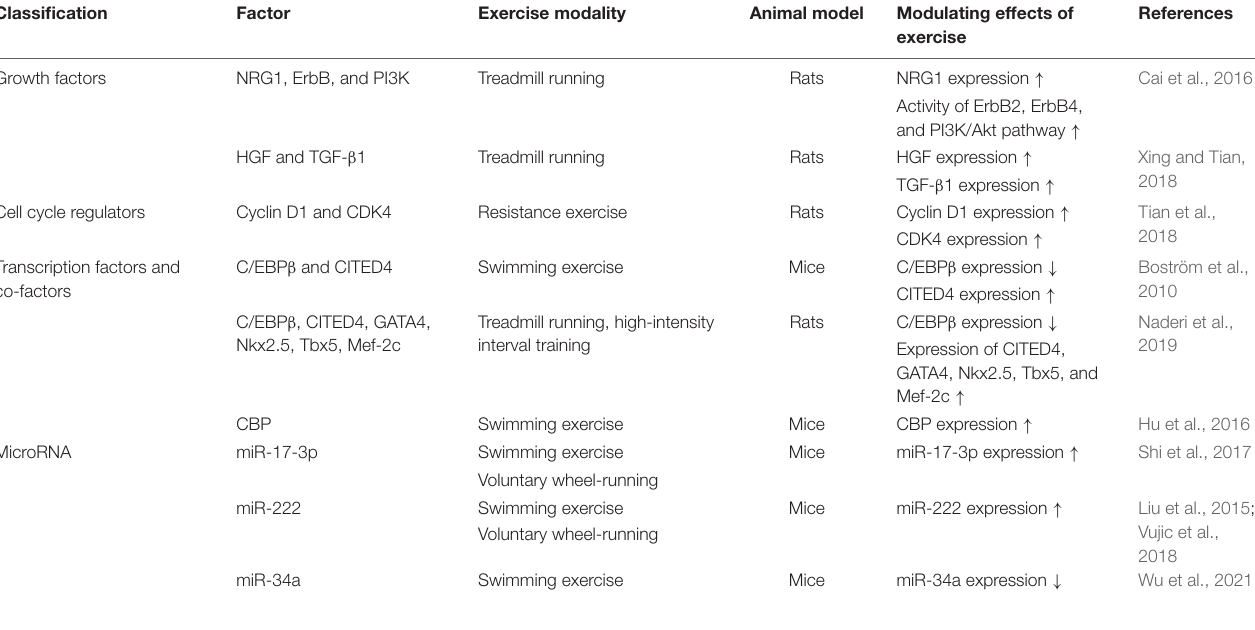
TABLE 1 | Factors related to exercise-induced cardiomyocyte